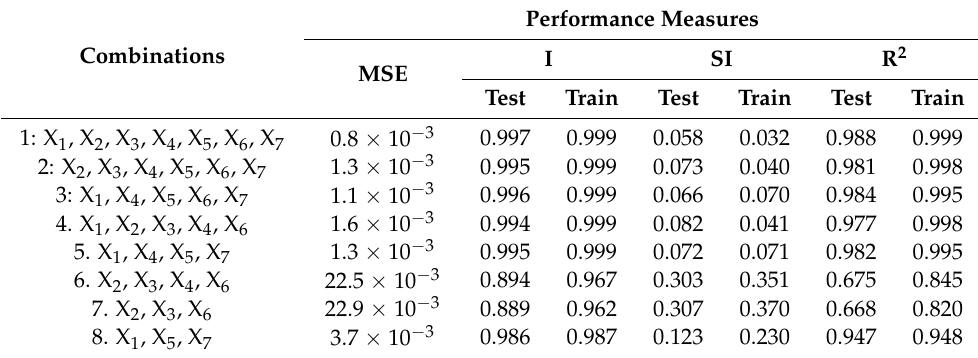
Table 5. Performance measures for analysis of different input variable